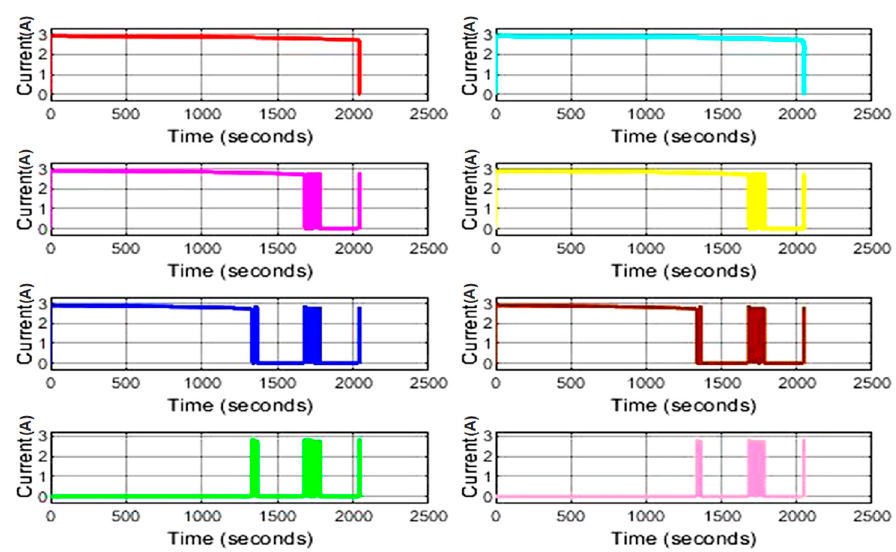
Figure 15. Primary current waveform in steady state for passive cell balancing—Current (Ampere) vs. time (s).